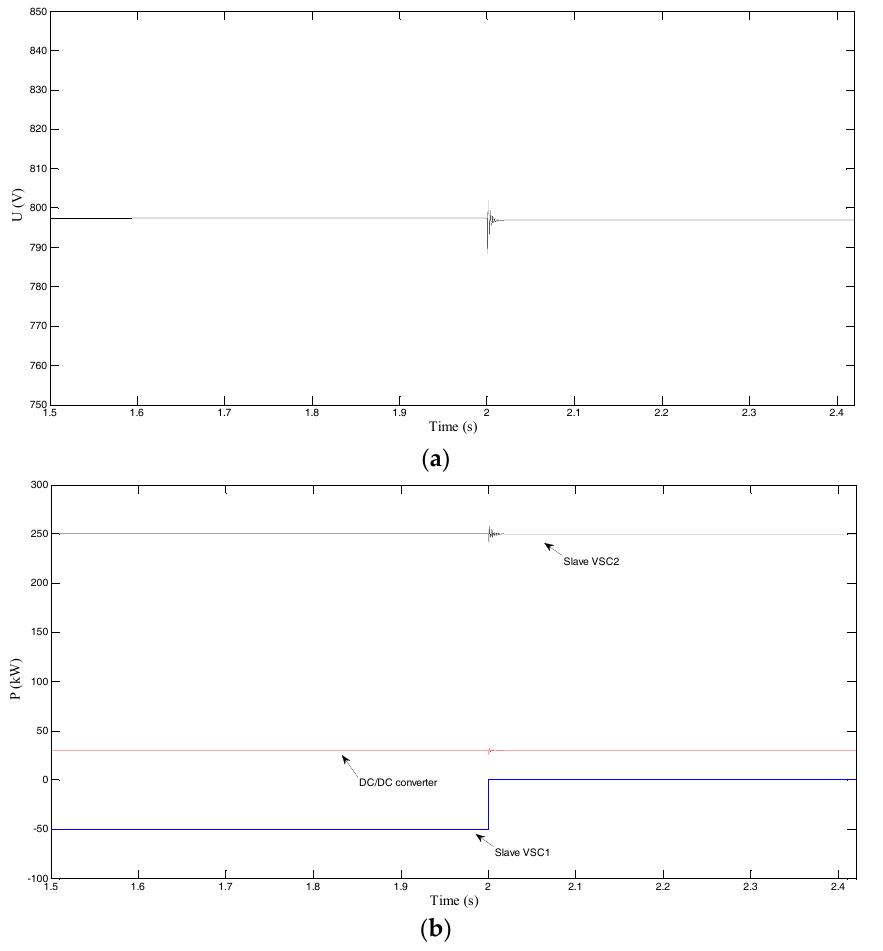
Figure 13. Simulation waveform when tripping slave VSC1 at t = 2 s with active stabilization control of the multi-terminal VSC and DC/DC converter: ( a ) U dc ; and ( b ) active power. When slave VSC1 is tripped, U dc appears as a divergent oscillation until instability without active stabilization control, as shown in Figure 12. After implementation of active stabilization control, when slave VSC1 is tripped ( P s1 decreases to 0 kW), U dc can quickly recover stability after a short